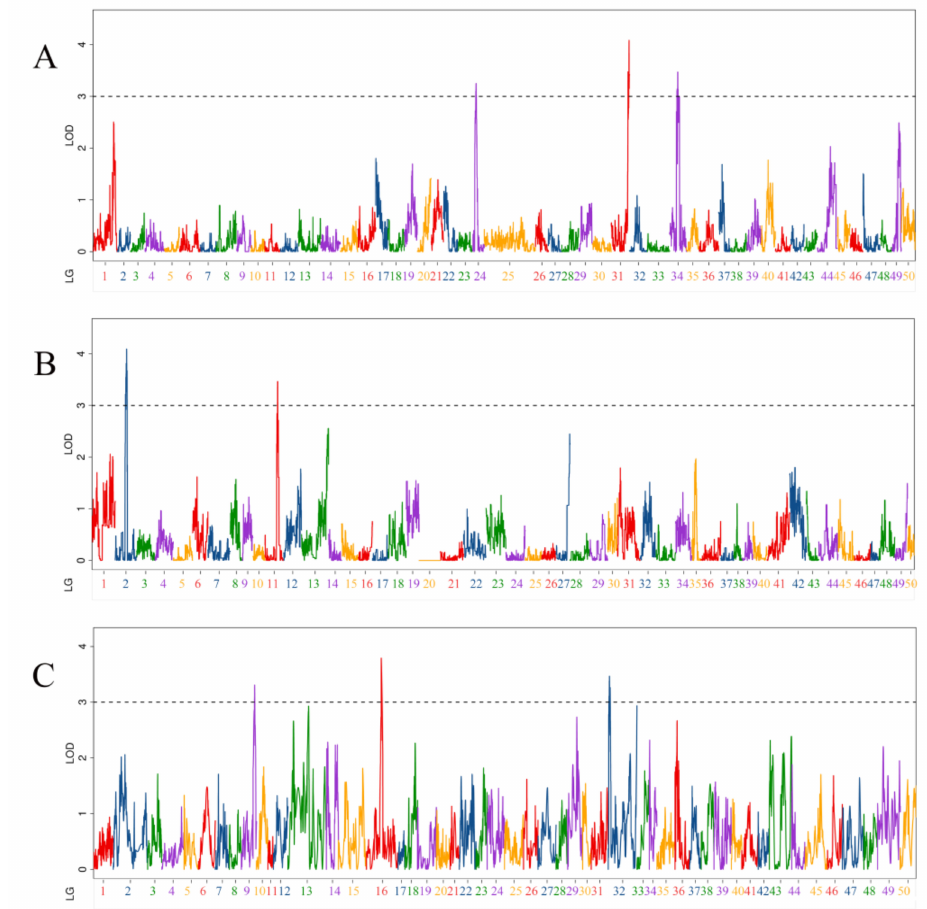
Figure 3. Distribution of body thickness–related QTL across 50 linkage groups of Yellow River carp from the maternal ( A ), paternal ( B ), and HH maps ( C